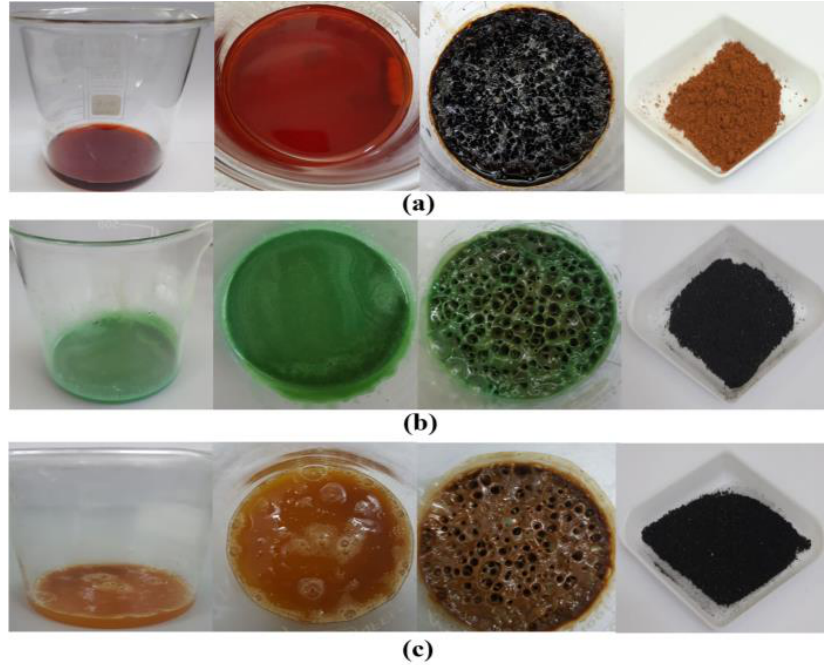
Figure 11. Stages for preparation of M 2 Zr 2 O 7 system; starting with the solution, gel, ceramic, then powder nanomaterial, ( a ) FeZr, ( b ) CuZr, and ( c )